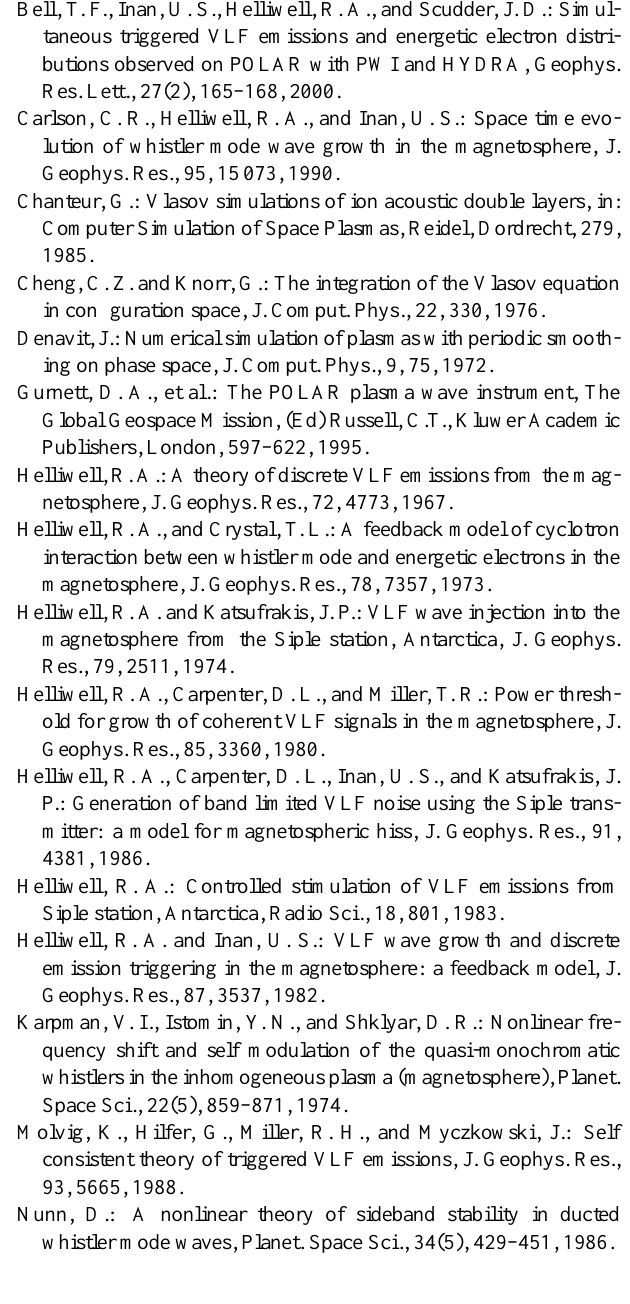
Fig. 20. Run 3. History of out of phase current − J I in units of J r (lin). In the faller GR, positive values are encountered upstream of the equator, which are directly instrumental in modifying wave phase such that wave frequency